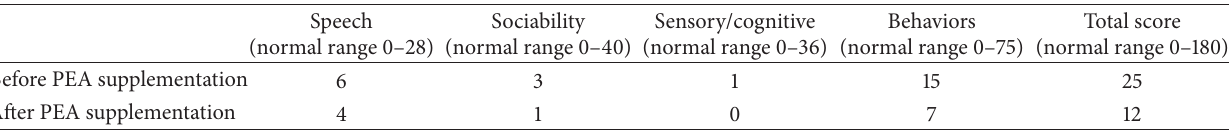
Table 1: Score distributions on a scale of Autism Treatment Evaluation Checklist (ATEC) in IF autistic patient before (baseline) PEA supplementation and three months later.